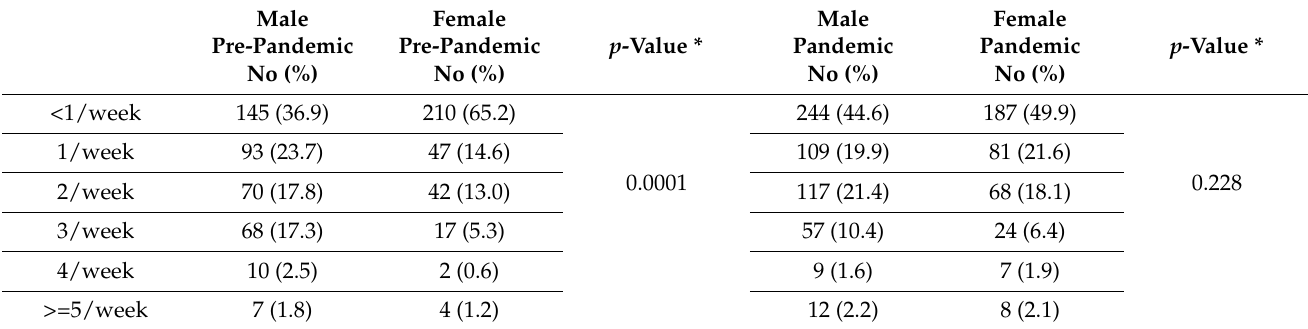
Table 5. The frequency of fast-food consumption per week.